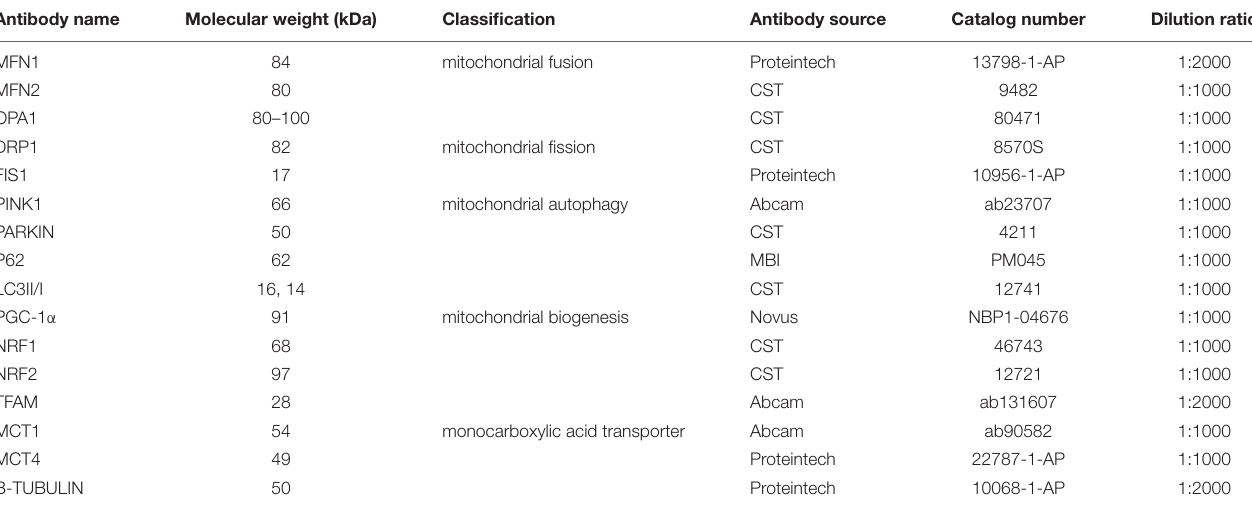
FIGURE 1 | The exercise paradigm of 6-week HIIT and exercise performance in the maximum test. (A) The exercise paradigm of 6-week HIIT. In the first and second week, the HIIT group completed warm-up (10 min × 10 m/min) and then 10 bouts of high-intensity running [4 min × (22–23) m/min], and separated by active rest (2 min × 10 m/min). In the third and fourth week, the HIIT group completed warm-up and then 10 bouts of high-intensity running [4 min × (26.5–28.5) m/min], and separated by active rest [2 min × (12–14.5) m/min]. In the fifth and sixth week, the HIIT group completed warm-up and then 10 bouts of high-intensity running [4 min × (30–33) m/min], and separated by active rest [2 min × (12–15) m/min]. (B) The exercise performance in the maximum test. The exercise performance of the HIIT group was, respectively, performed at the end of adaptive training, the second and the fourth week of training. TABLE 1 | Antibodies used for WB analysis of mice